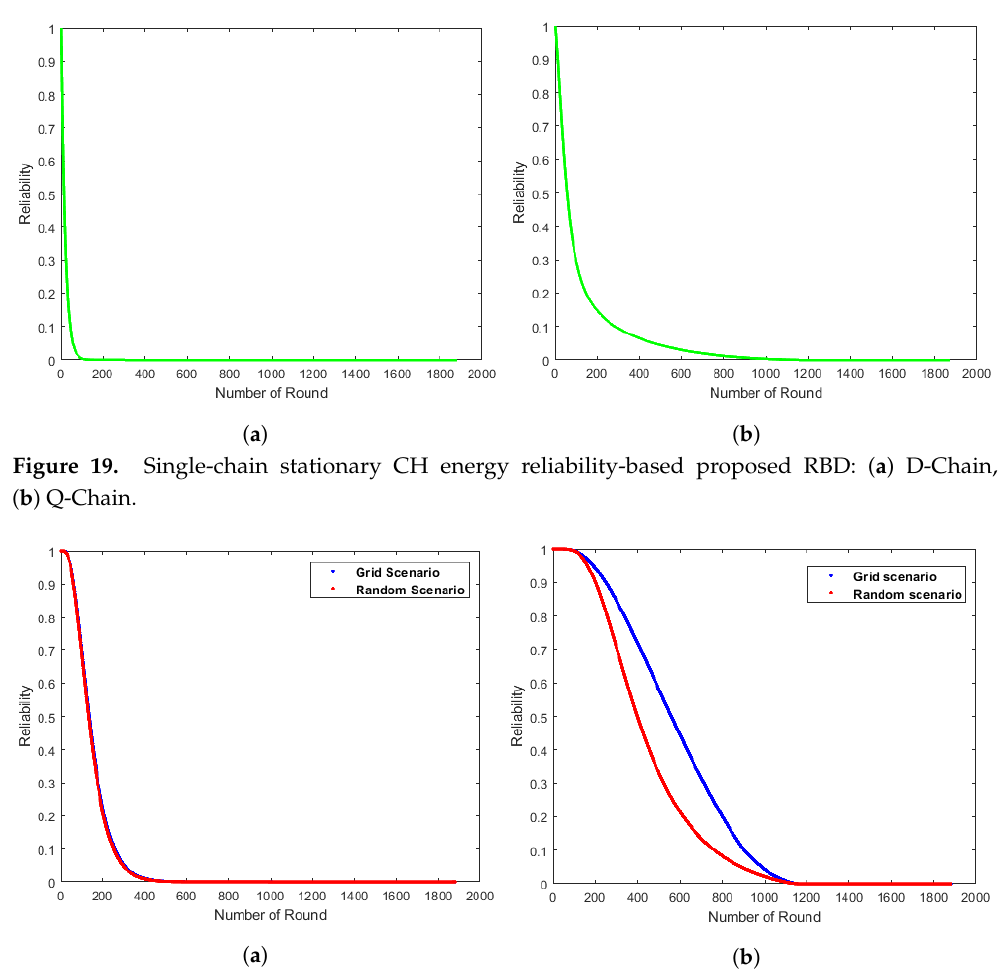
Figure 20. Multi-chain single-hop stationary CHs energy reliability-based proposed RBD: yellow